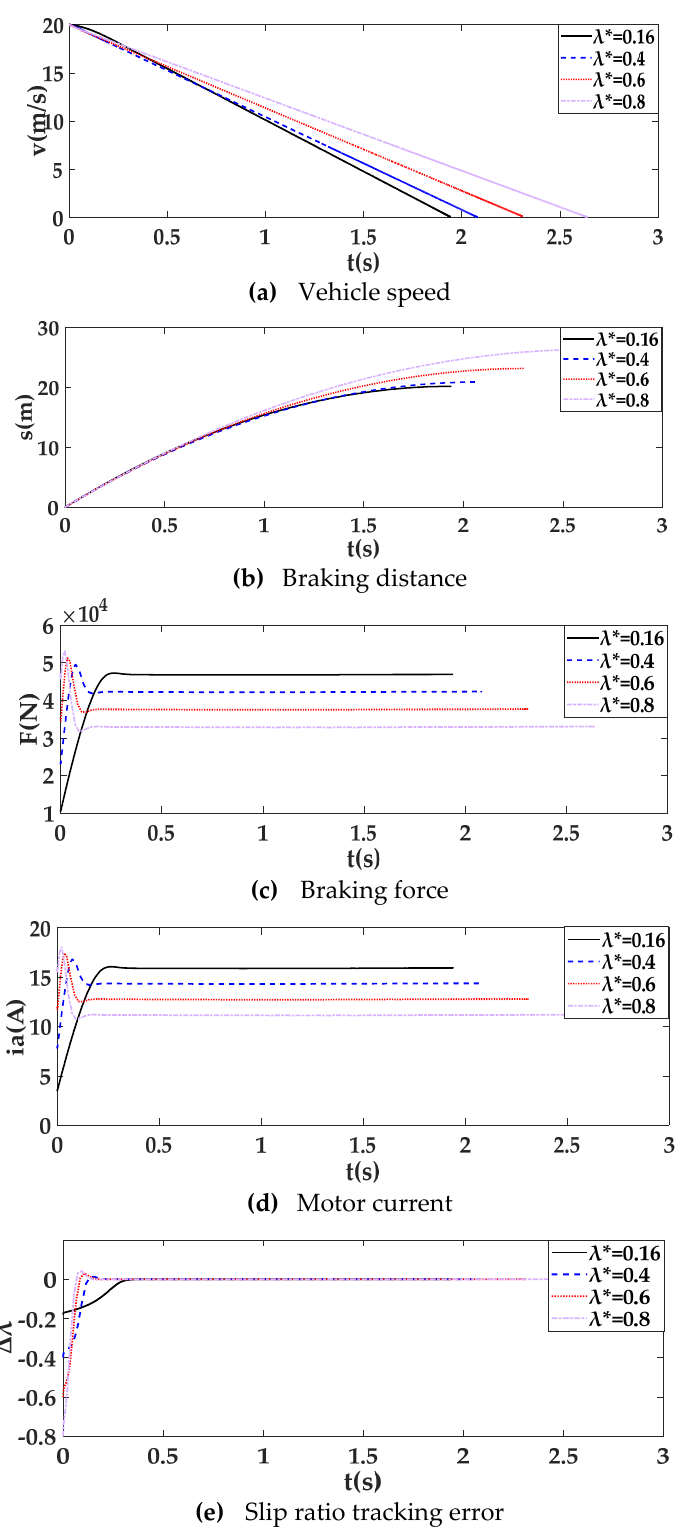
Figure 9. Cement road surface simulation.